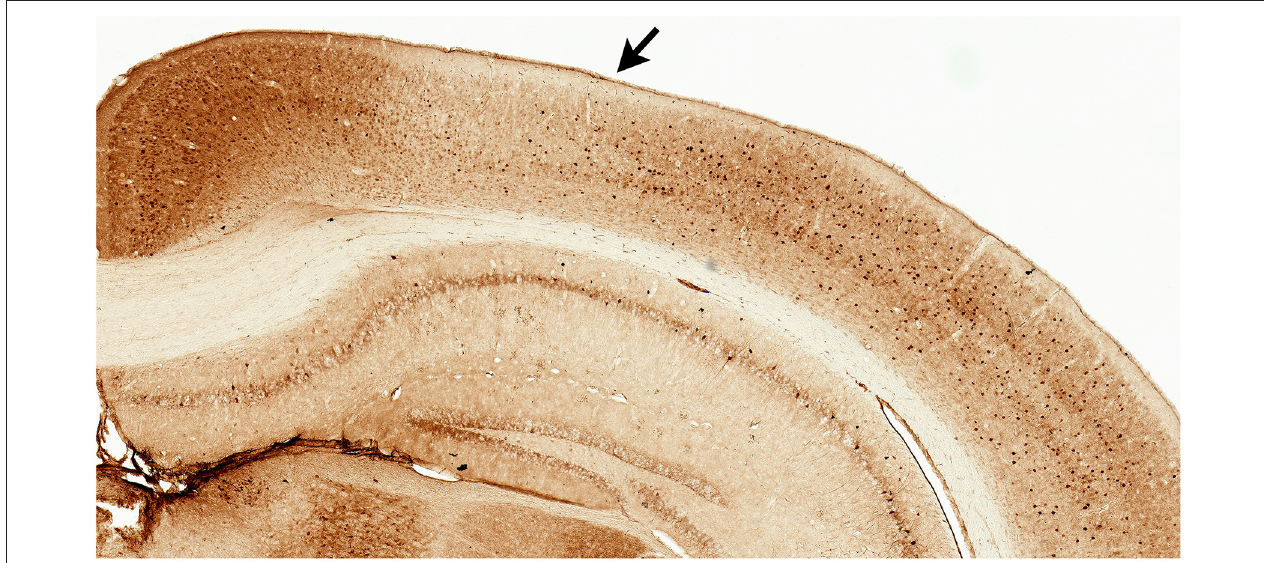
FIGURE 1 | Parvalbumin stained tissue for region of interest analyses. Example of facilitated identification of a region of interest, parietal cortex (PC), using adjacent parvalbumin stained tissue. PC (arrow) can be readily identified by the emergence of layer IV (medial boundary) and ending at the lateral border where parvalbumin staining becomes more